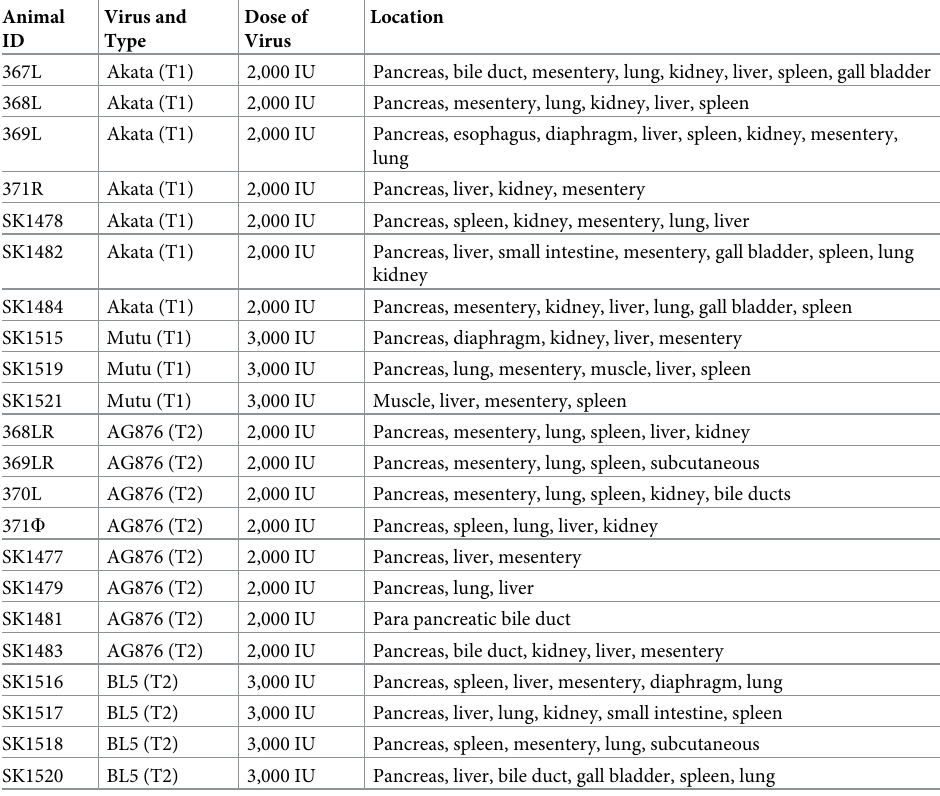
Table 1. The location of the various tumors generated in CBH mice used in this study. Animal Virus and Dose of ID Type